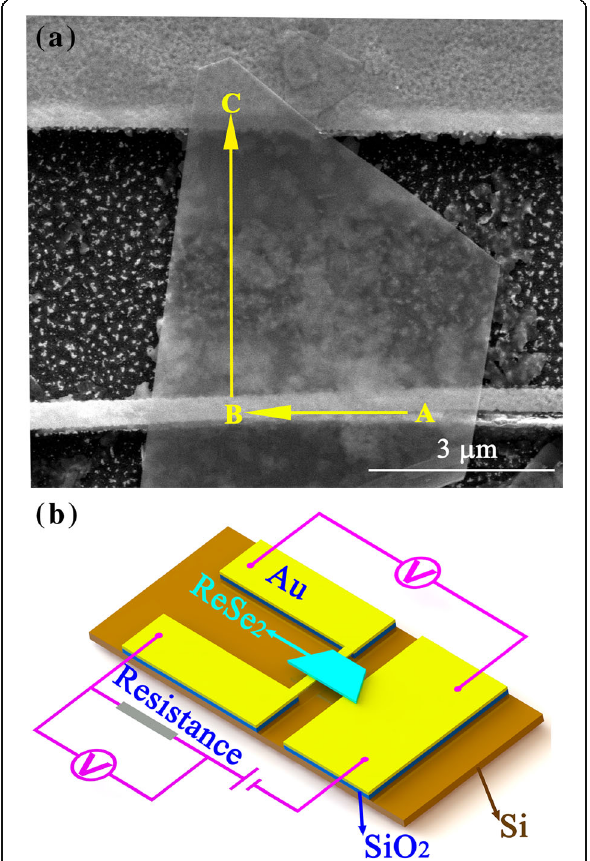
Fig. 1 a SEM image of the device in vertical view to the substrate and the positive current direction and b schematic diagram of the measurement device